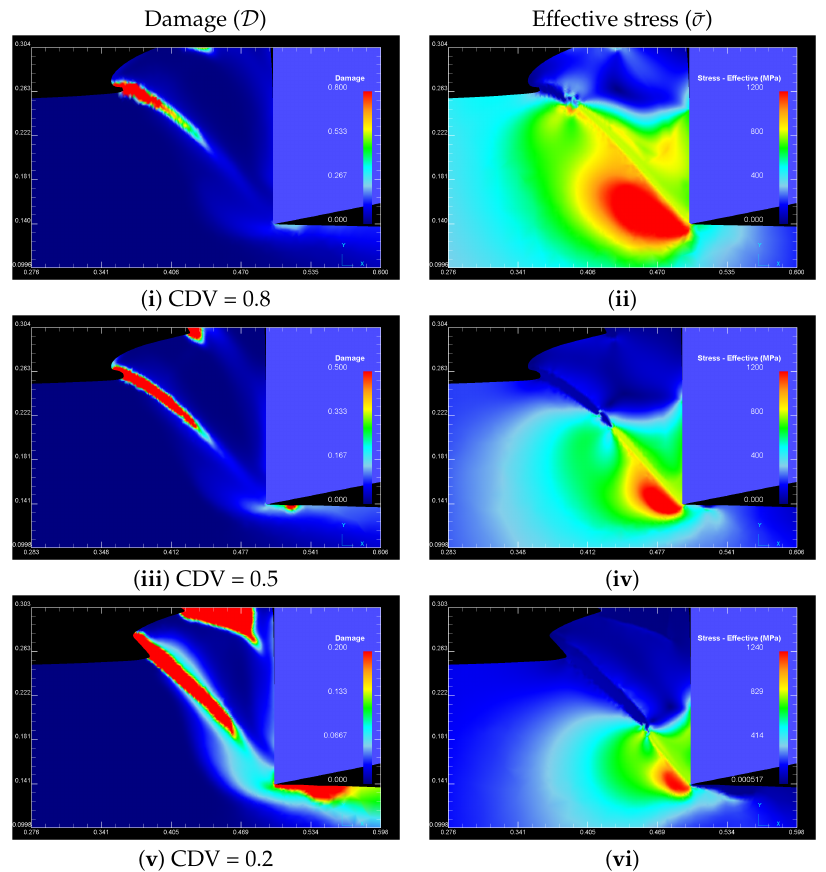
Figure 7. The failure mode mechanism against the critical damage value (CDV); snapshots are taken at the final stage during one cycle of ASB formation: ( i ) Damage and ( ii ) effective stress contour using CDV = 0.8; ( iii ) damage and ( iv ) effective stress contour using CDV = 0.5; ( v ) damage and ( vi ) effective stress contour using CDV = 0.2 ( v = 200 m/min, feed = 0.10 mm/rev, rake angle γ = 0 ◦ ). Simulations using a minimum mesh size of h min ≈ 0.4–1.6 µ